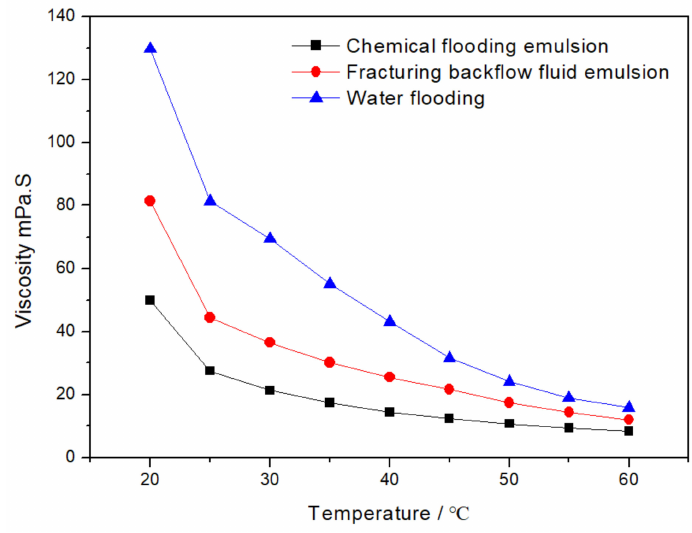
Figure 1. Viscosity–temperature curve of WF, CF, and FB